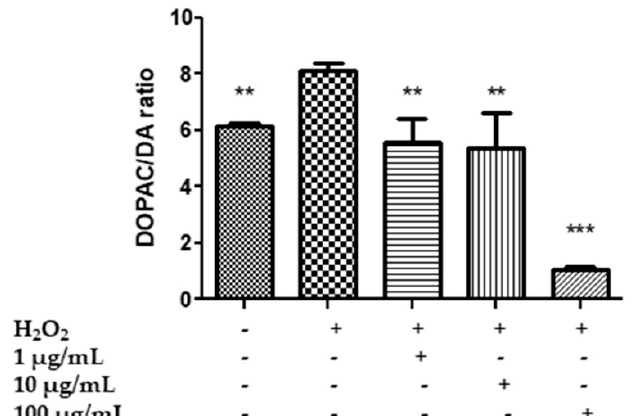
Figure 5. Effect of the HAE acetone water extract (1–100 µ g/mL) on dopamine turnover, measured as DOPAC/DA ratio, in hypothalamic HypoE22 cells exposed to H 2 O 2 ( µ M). ANOVA p < 0.0001; ** p < 0.01, *** p < 0.001 vs. H 2 O 2 .